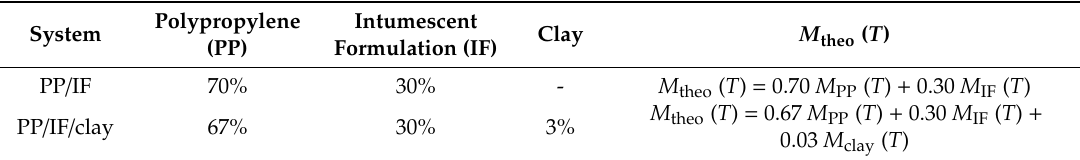
Table 1. Concentration (% m / m ) of the components in each system studied and equations used to construct the theoretical thermogravimetric analysis (TGA) curves.